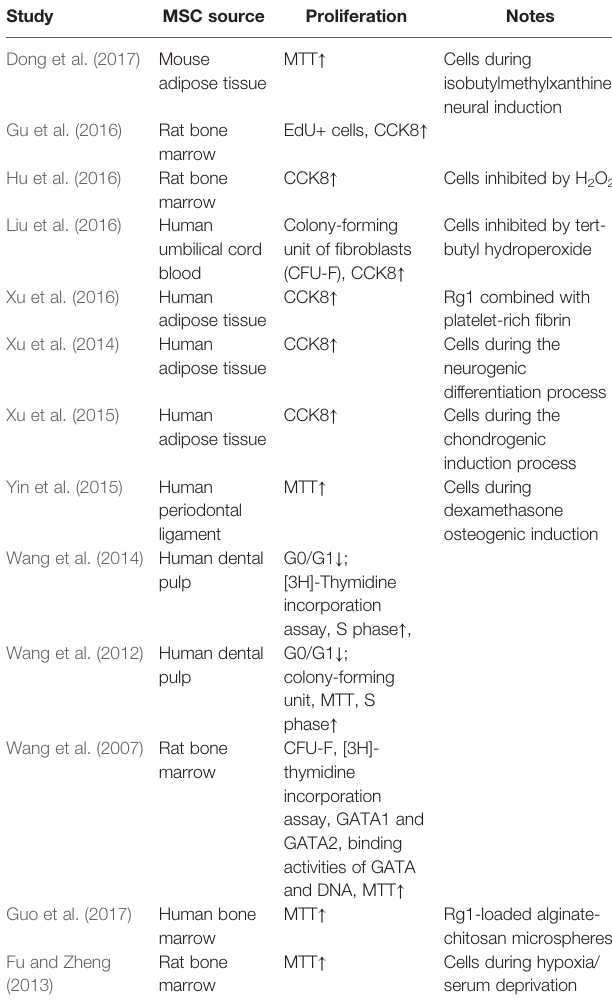
TABLE 1 | Ginsenoside Rg1 promotes MSC proliferation in vitro